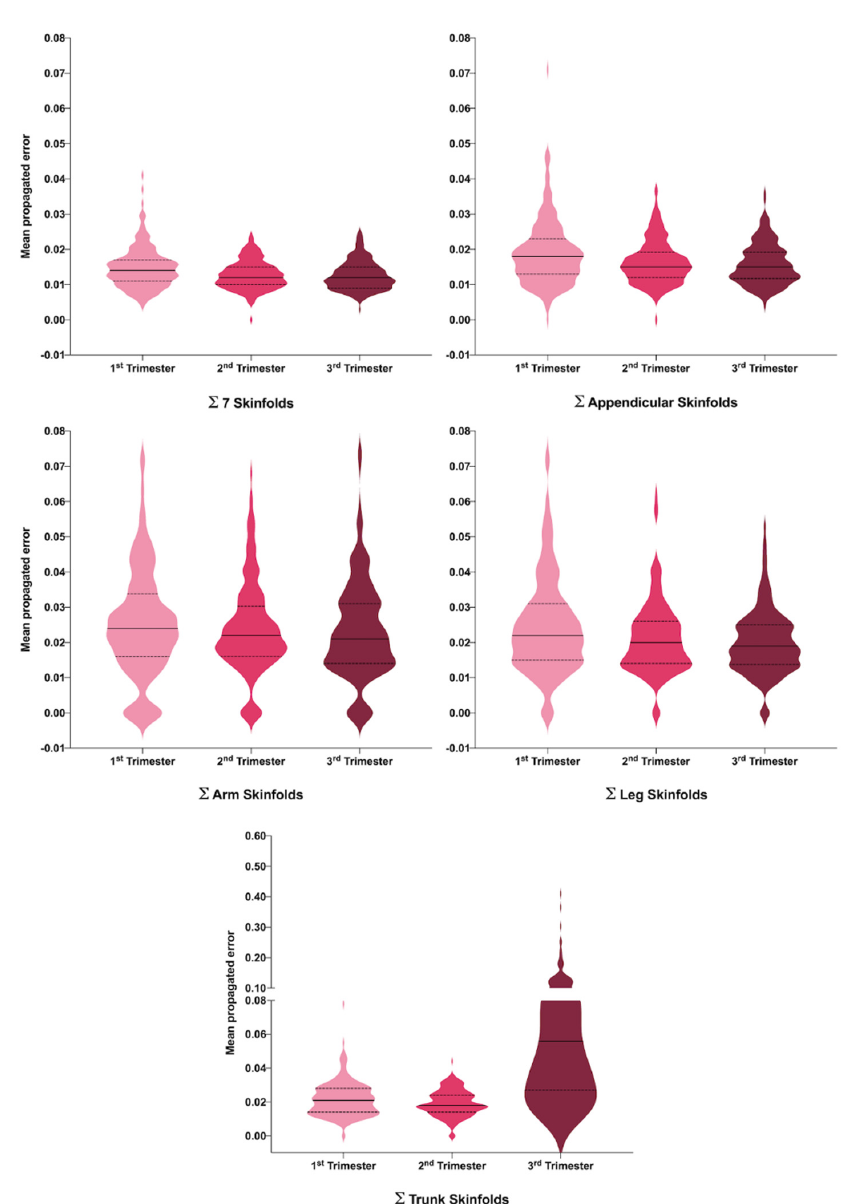
Figure 1. Reliability and agreement of sum skinfolds for the three trimesters during pregnancy represented by violin plots. Anthropometric: ∑ 7SFT (mm). Sum of seven skinfolds [triceps + subscapular + biceps + iliac crest + abdominal + mid-thigh + calf (mm)]; ∑ Appendicular SFT (mm). Sum of appendicular skinfolds [triceps + biceps + mid-thigh + calf (mm); ∑ Arm SFT (mm). Sum of arm skinfolds [triceps + biceps (mm)]; ∑ Leg SFT (mm). Sum of leg skinfolds [mid-thigh + calf (mm)]; ∑ Trunk SFT (mm). Sum of trunk skinfolds [subscapular + iliac crest + abdominal (mm)].